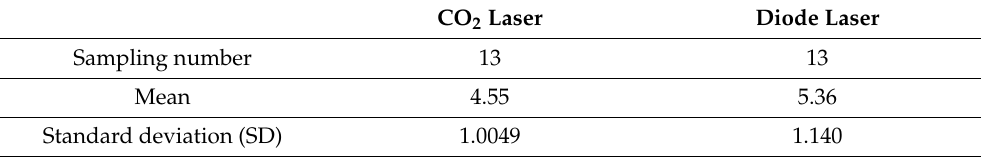
Table 3. Comparison between the average eruptions obtained with the two different types of lasers. T 0.0471 Degrees of freedom 24 P (significance level) 0.7280